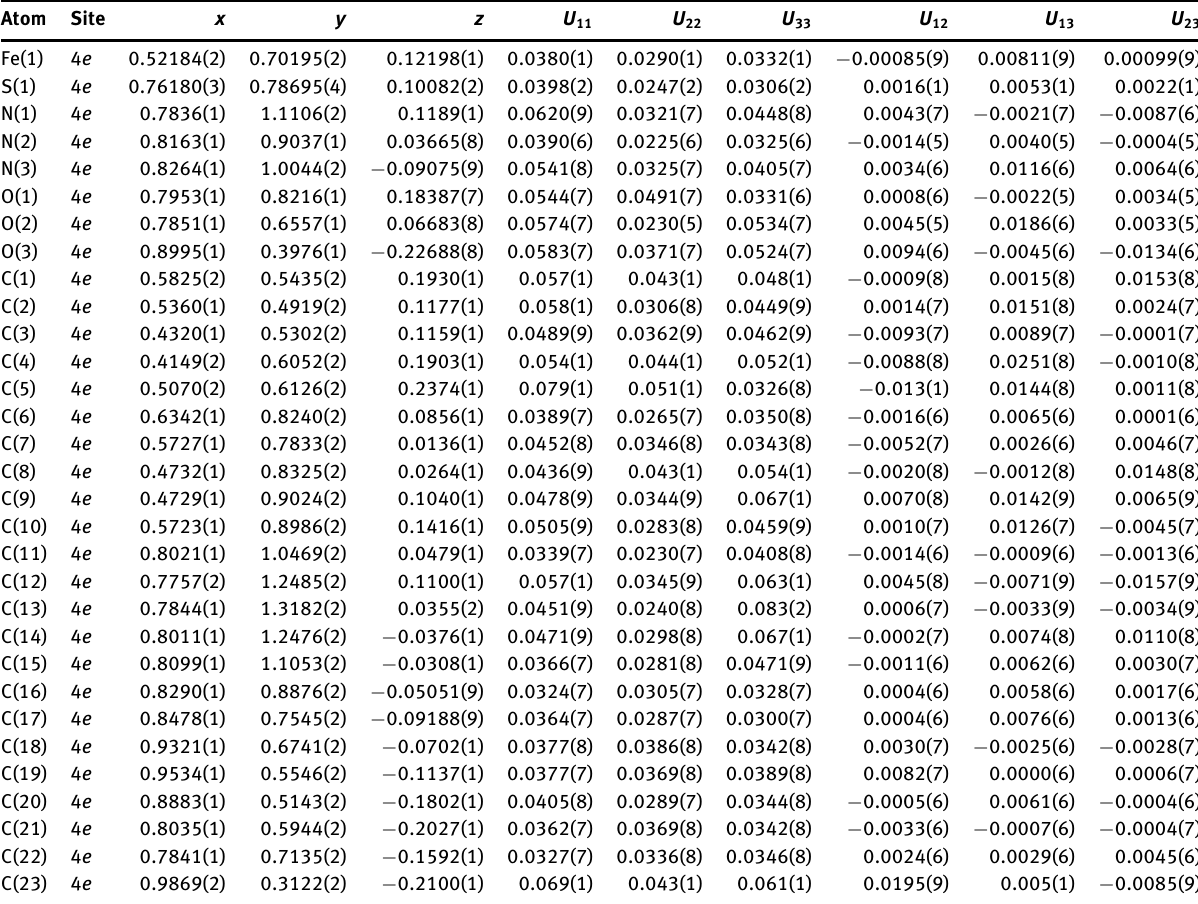
Table 3: Fractional coordinates and atomic displacement parameters (Å 2